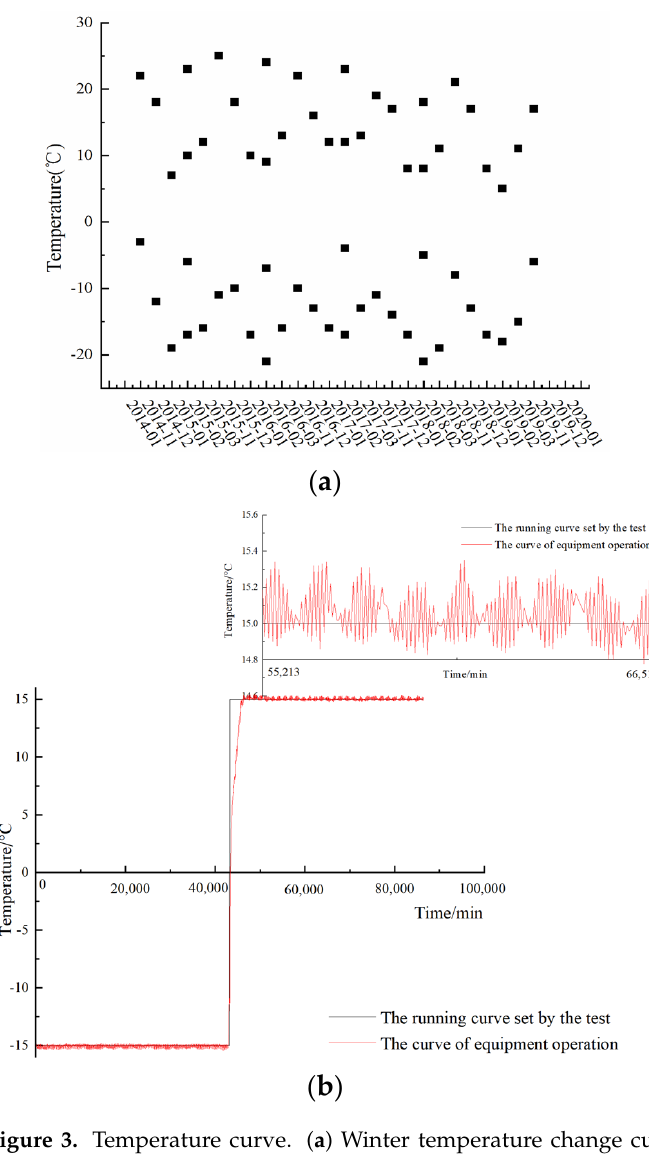
Figure 3. Temperature curve. ( a ) Winter temperature change curve in Xining (in recent years); ( b ) sine curve set during the test.